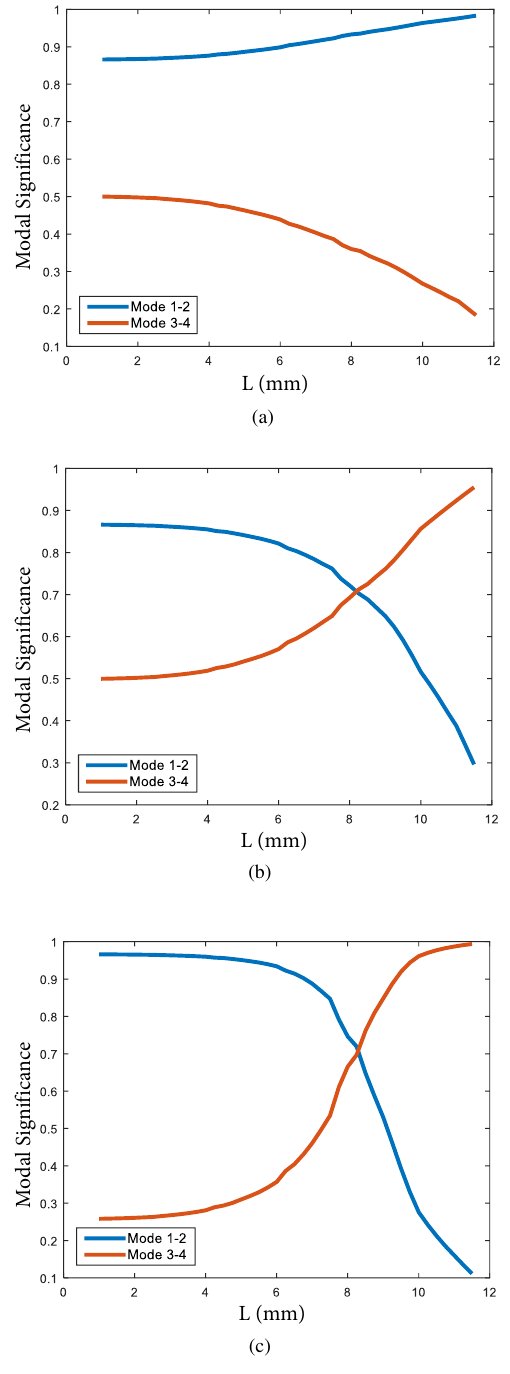
Figure 6: Modal significance for square-slot reflectarray ele- ments. (a) h=4. (b) h=8 mm. (c) h=10